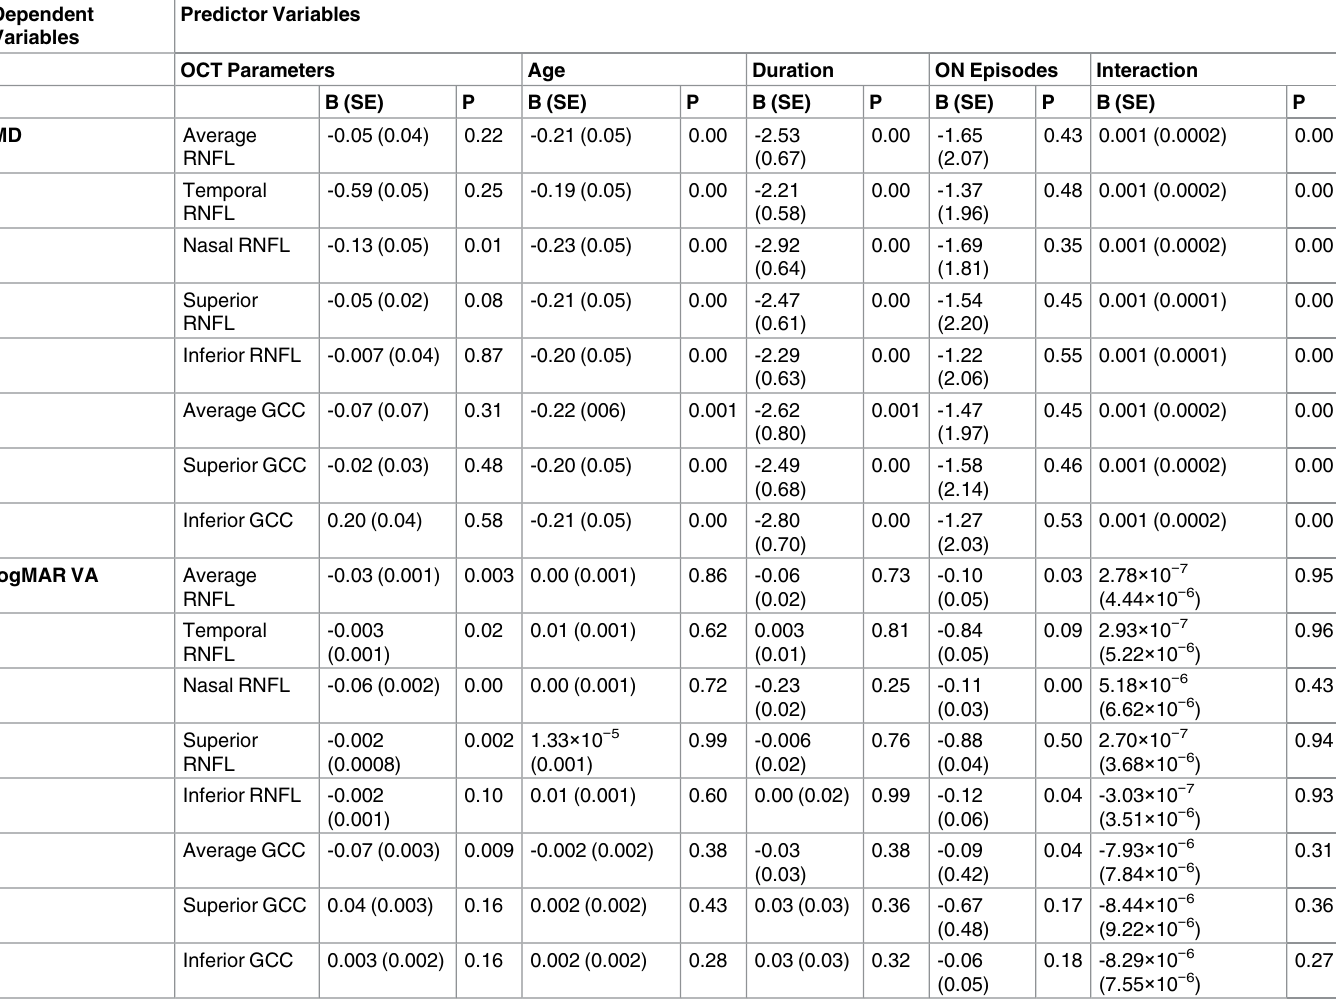
Table 7. Generalized Estimating Equation Regression Analysesfor Factors associated with Visual Function in Aquaporin-4 Antibody-Negative Eyes. Dependent Predictor Variables